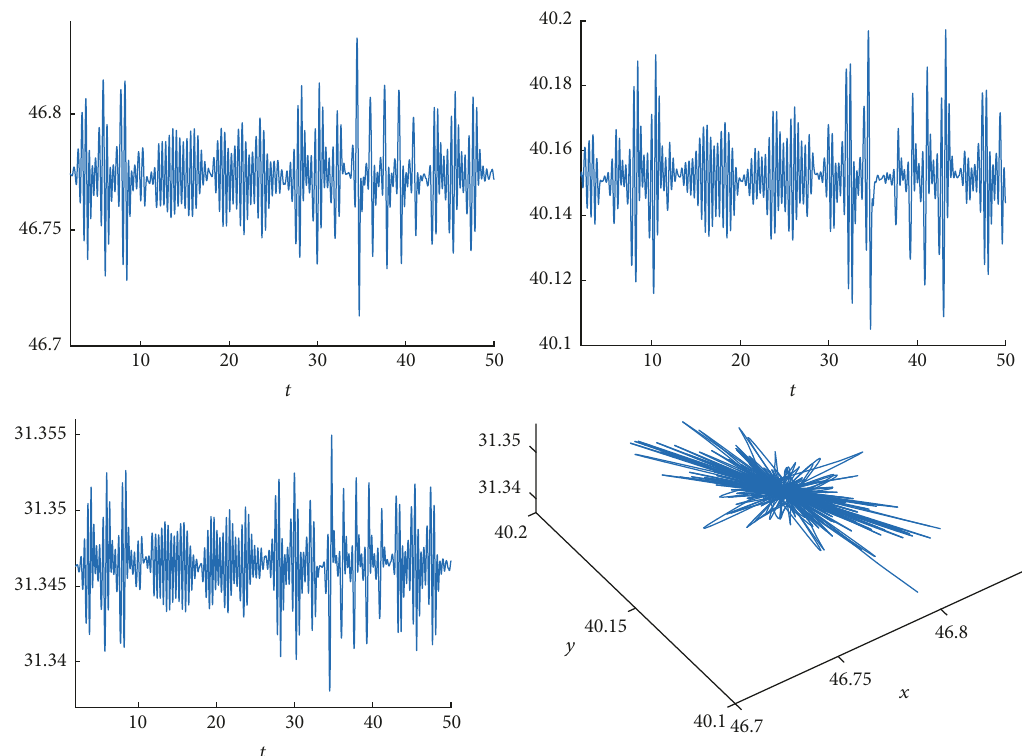
Figure 6: Dynamical behaviors and phase space trajectories of the three marine